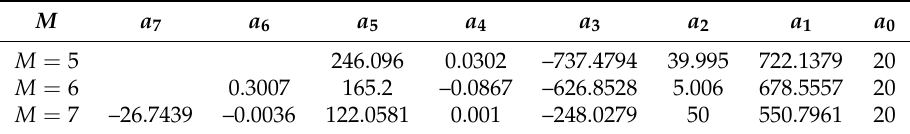
Table 1. The phase coefficients of signals in numerical example.